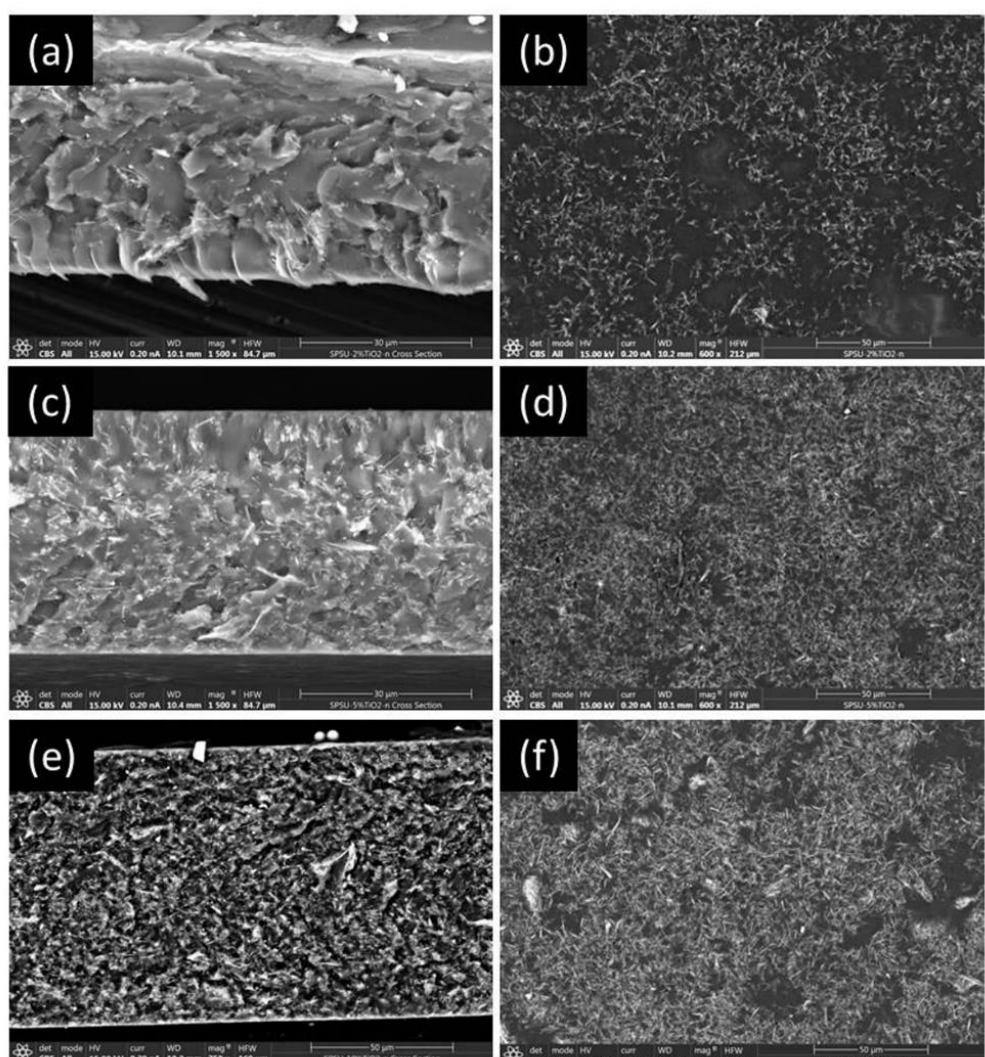
Figure 4. SEM images of the cross-section and surface of the composite membranes with sPSU/2%TiO 2 (B) ( a , b ), 5%TiO 2 (B) ( c , d ) and 10%TiO 2 (B) ( e , f ).